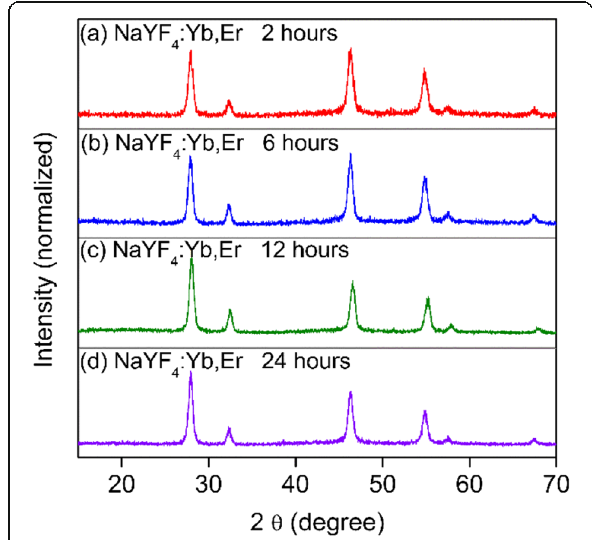
Fig. 3 XRD patterns of NaYF 4 : Yb, Er crystals which were synthesized without α – NaGdF 4 core existing with different reaction times. ( a ) 2 h, ( b ) 6 h, ( c ) 12 h, and ( d ) 24